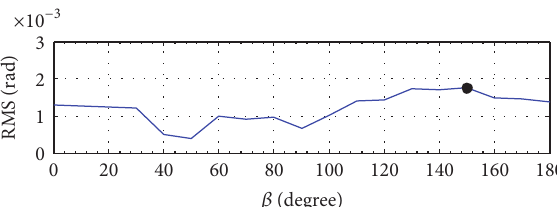
Figure 9: The torsional response of the building model versus the angle of dynamic excitation loading and the bullet indicates the maximum RMS value of torsion in radian